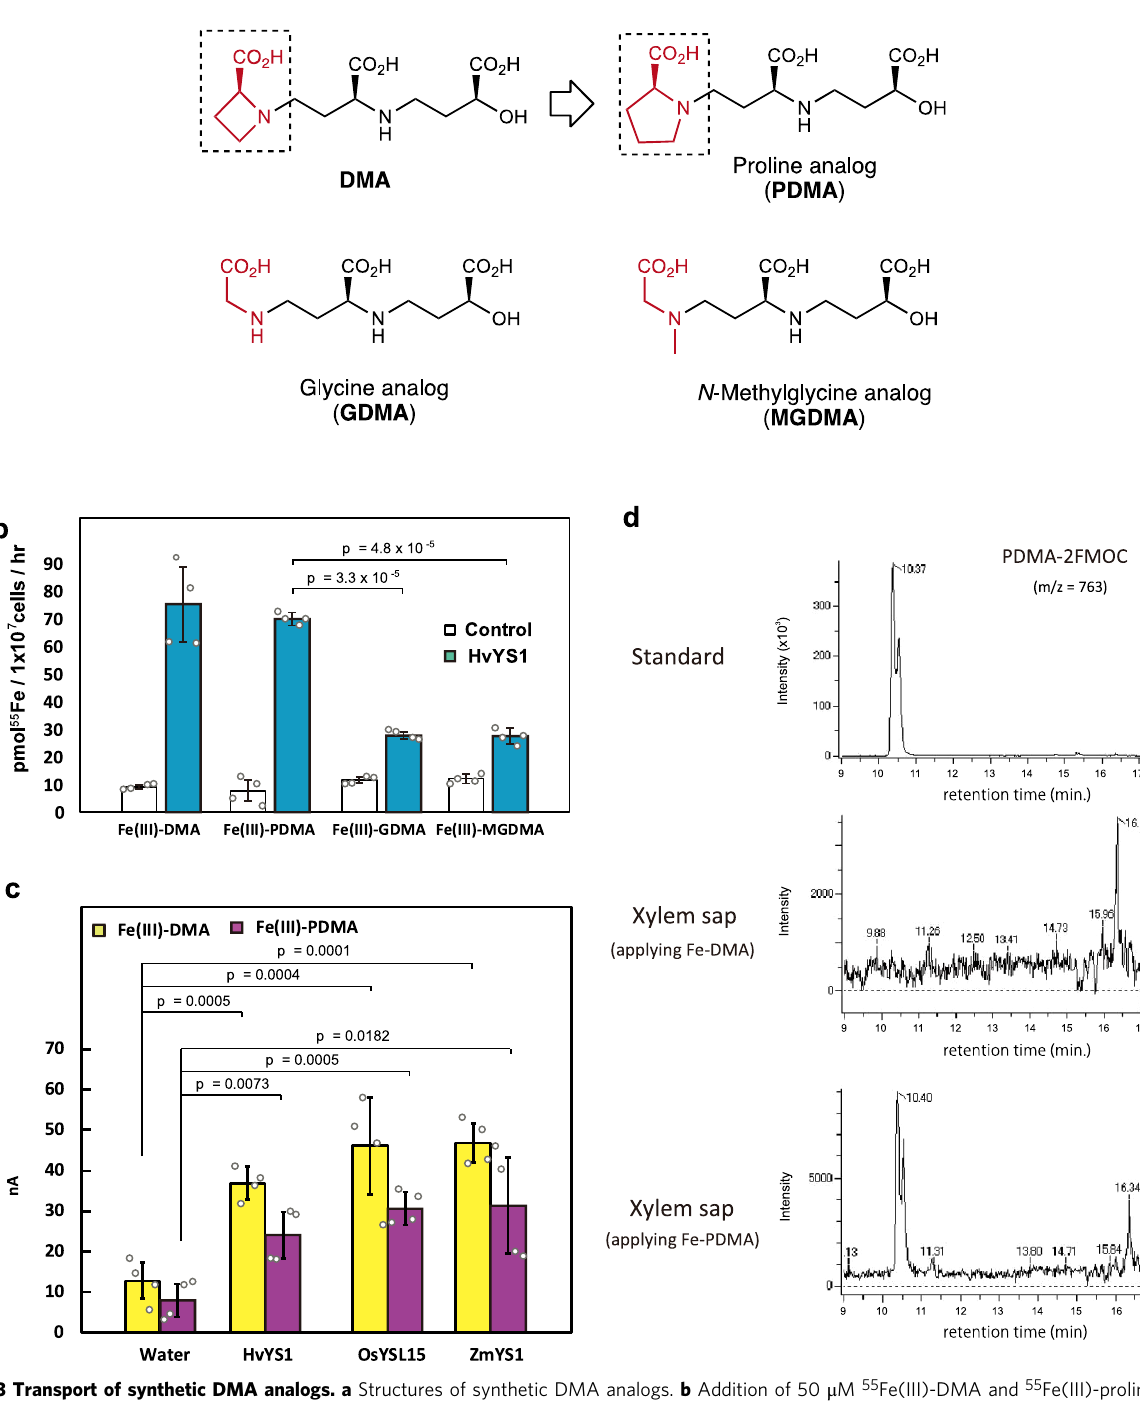
Fig. 3 Transport of synthetic DMA analogs. a Structures of synthetic DMA analogs. b Addition of 50 μ M 55 Fe(III)-DMA and 55 Fe(III)-proline deoxymugineic acid (PDMA) to HvYS1-expressing Sf9 insect cells (1 × 10 7 ) enhanced their Fe(III)-transport activity. In contrast, 55 Fe(III)-GDMA and 55 Fe (III)-MGDMA only marginally enhanced the Fe(III)-transport activities of the cells. Each Fe(III) complex contained 10 mol% radioactive 55 Fe. Sf9 insect cells transfected with empty vector were used as a control. Values are means with standard deviations of the four cell lysate replications (two-tailed t -test for Fe(III)-PDMA in HvYS1). c Fe(III)-transporting activities of synthetic DMA and PDMA in Xenopus oocytes injected with HvYS1 , OsYSL15, or ZmYS1 cRNA, or water (negative control) were measured by two-electrode voltage clamp analysis. Values are means with standard deviations of the four replicates (two-tailed t -test for water injection). d Detection of PDMA derivatized using 9- fl uorenylmethoxycarbonyl chloride (FMOC) by liquid chromatography-time-of- fl ight mass spectrometry (LC-TOF-MS) analysis in the xylem sap of rice plants supplied with Fe-DMA and Fe-PDMA in the nutrient solution. DMA 2 ′ -deoxymugineic acid, PDMA proline-2 ′ -deoxymugineic acid, GDMA glycine-2 ′ -deoxymugineic acid, MGDMA N -methylglycine- 2 ′ -deoxymugineic acid, HvYS1 Hordeum Vulgare yellow stripe 1, OsYSL15 Oryza Sativa yellow stripe 1 like transporter 15, ZmYS1 Zea mays yellow stripe 1.